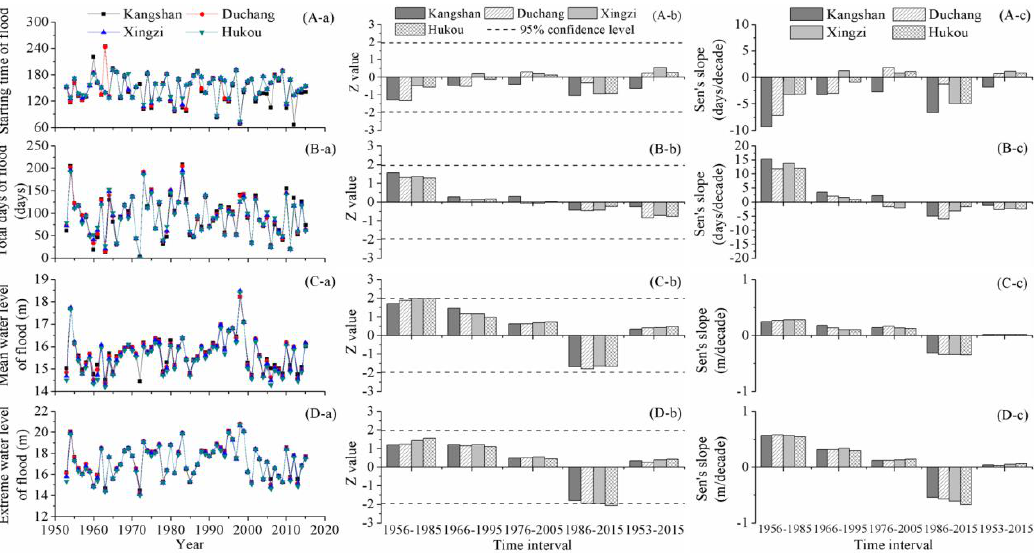
Figure 5. Change features of flood in Poyang Lake: (i) the sub-figures labeled (A–D) display change features of starting time of flood, total days of flood, mean water level of floods, and extreme water level of floods, respectively; and (ii) the sub-figures labeled (a–c) display annual values, Z values, and Sen’s slopes, respectively.